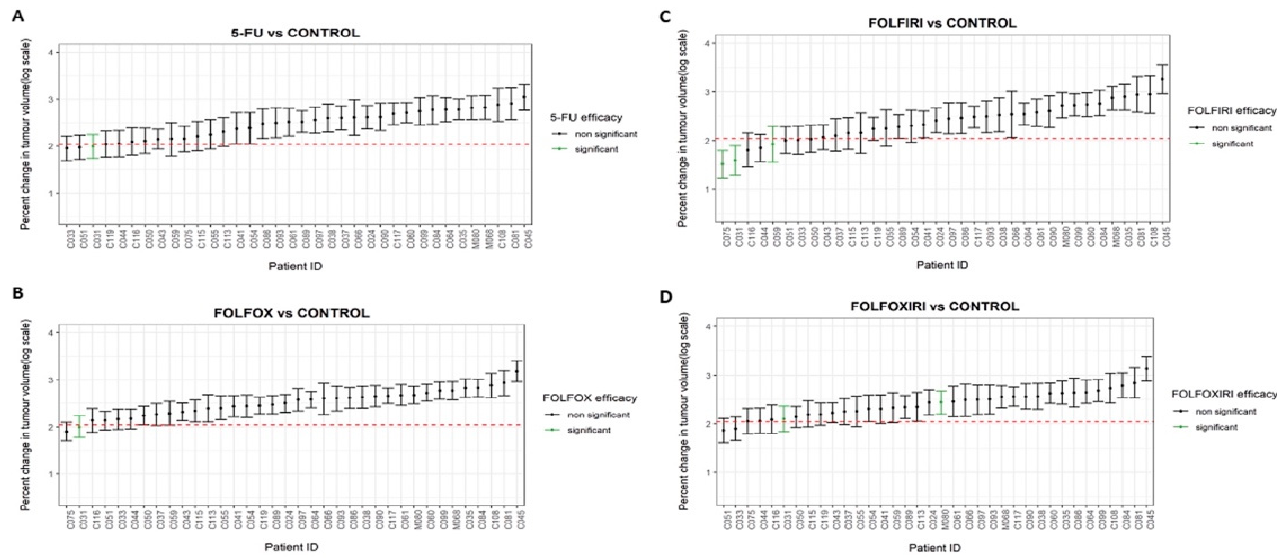
Figure 2. Error bars represent 95% confidence intervals of the % ∆ V calculated using random-effects model. Subgroup analyses for the treatment efficacy of 5-FU ( A ), FOLFOX ( B ), FOLFIRI ( C ), and FOLFOXIRI ( D ), with respect to each patient control were also conducted. Green 95% confidence intervals represent a statistically significant difference to the control.